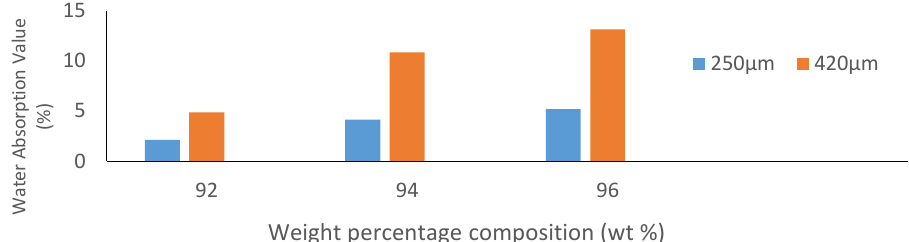
Figure 5 : The sandpaper samples’ water absorption